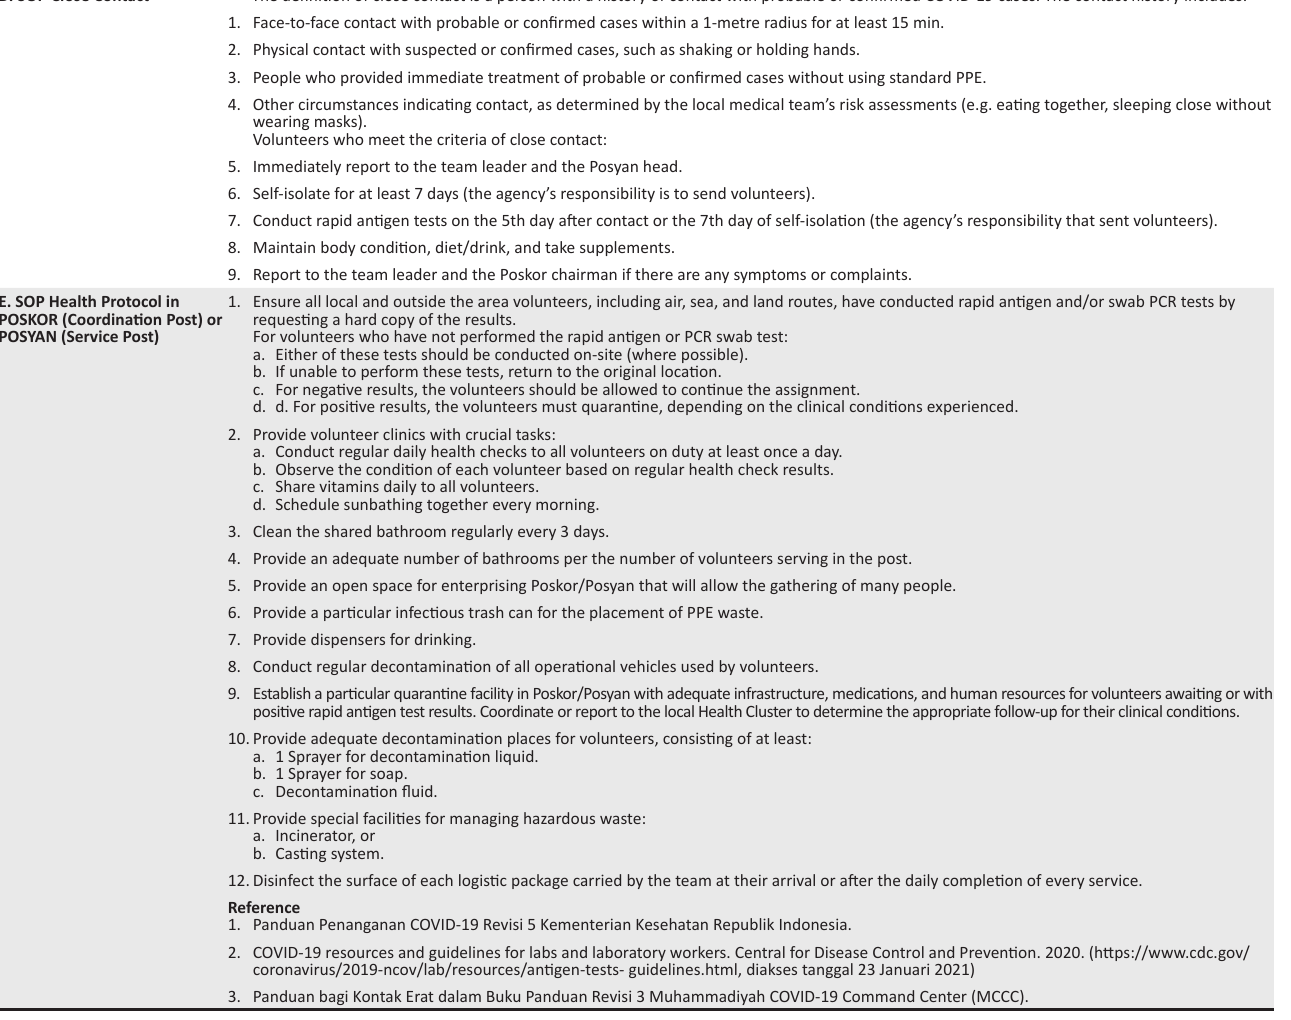
TABLE 2 (Continues…): Standard operational procedure for the assignment of Muhammadiyah volunteers during the COVID-19 pandemic. D. SOP Close Contact